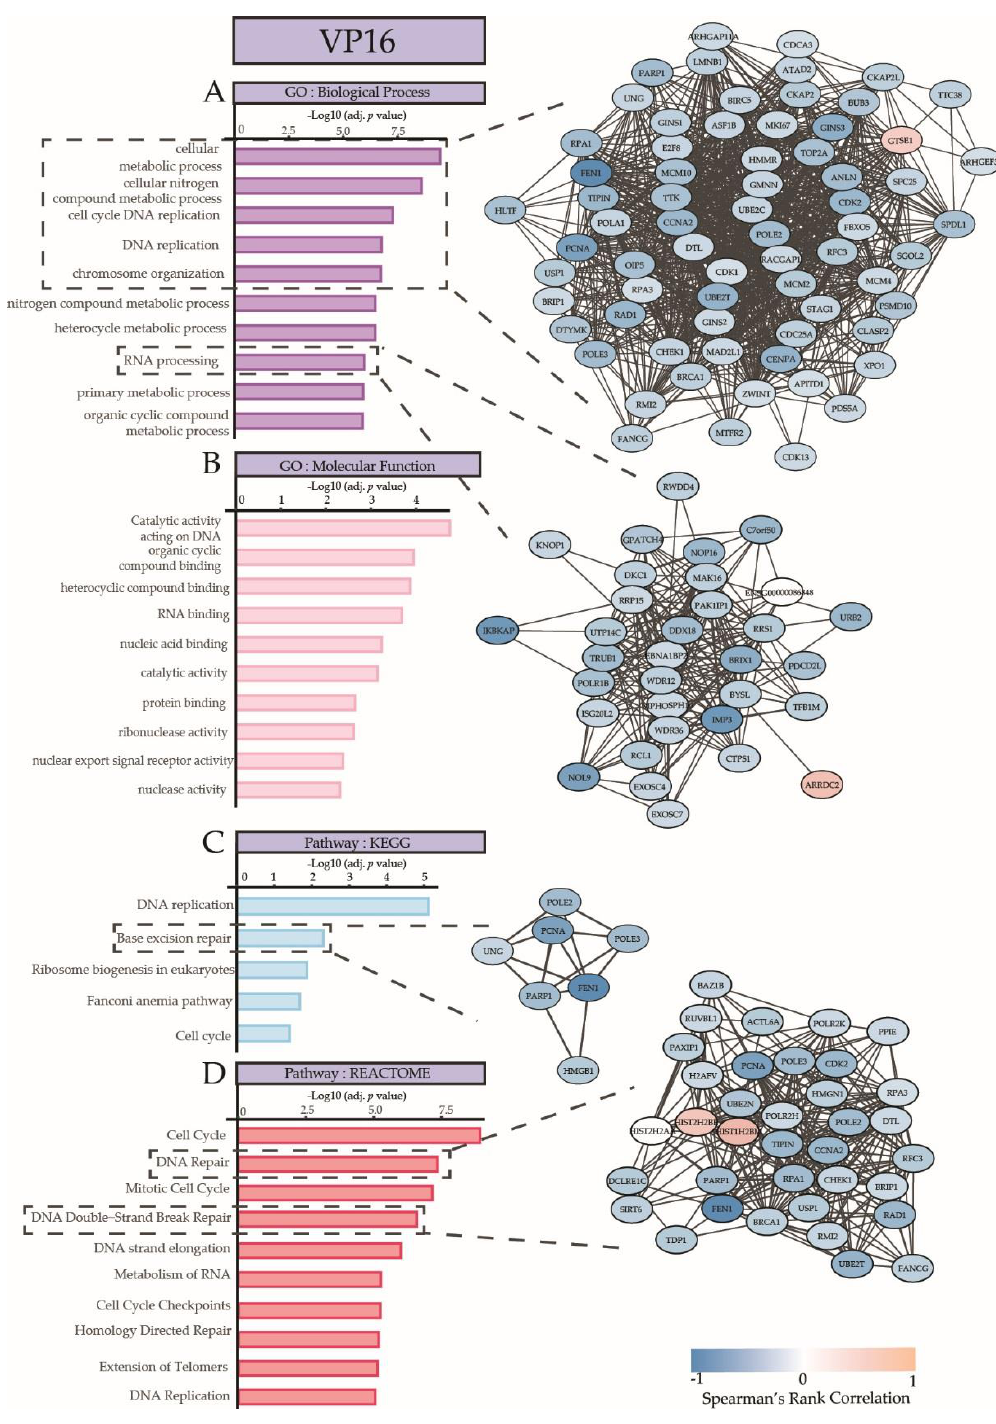
Figure 5. Summary of Gene Ontology Analysis and Pathway analysis on genes that are associated with ex vivo VP16 response, ranked according to adjusted p -values. ( A ) Biological processes and ( B ) molecular functions linked to genes associated with response towards VP16. Pathway terms from ( C ) KEGG and ( D ) REACTOME with significantly enriched genes that are associated with VP16 response. An interaction network visualization on the right depicts the gene–gene interactions for selected processes, pathways, or functions, indicated with dotted lines. Blue indicates a negative correlation and orange–red indicates a positive correlation with drug resistance.